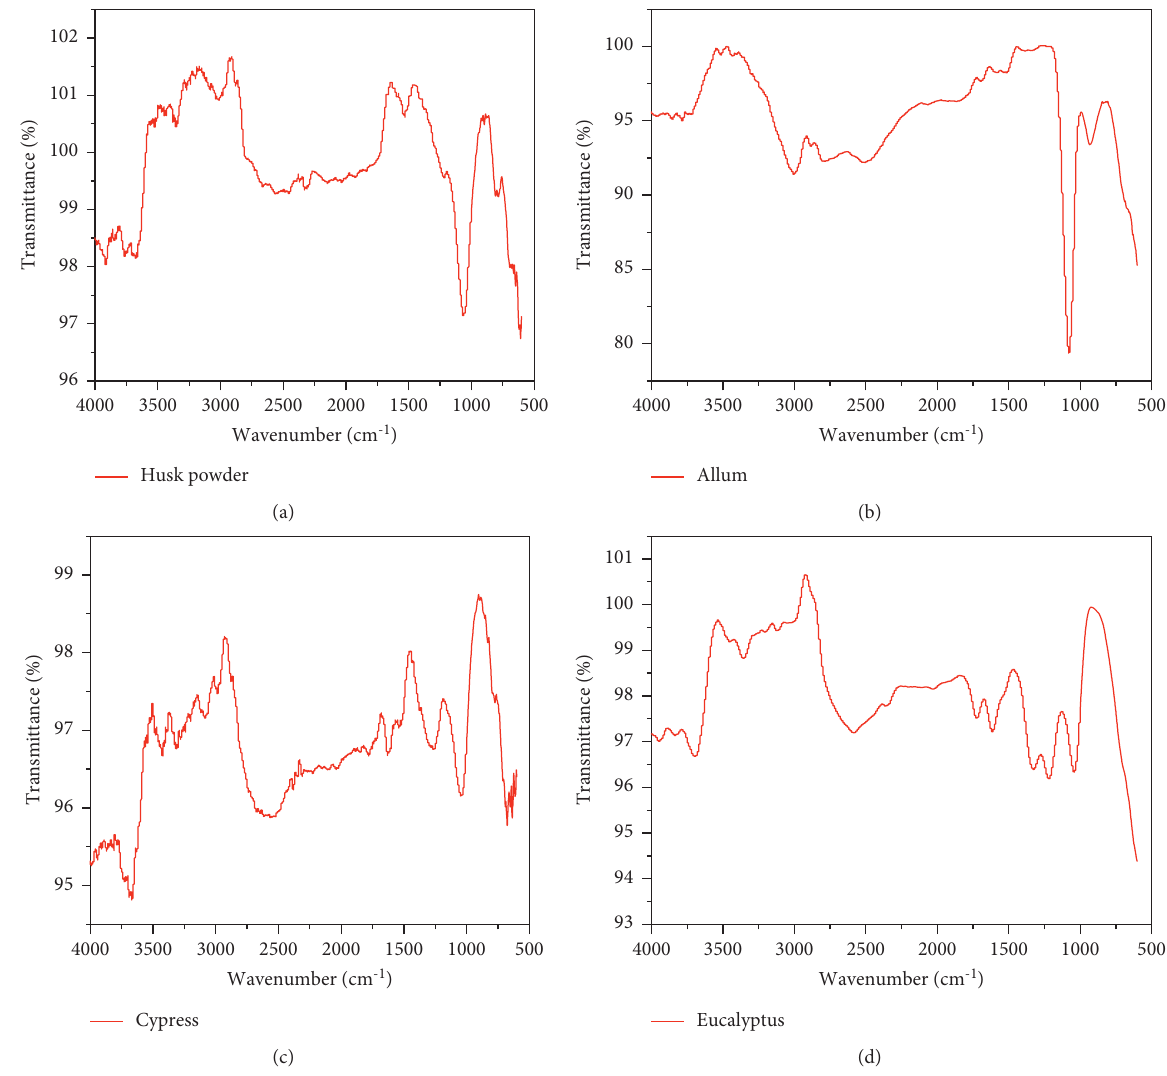
Figure 3: FTIR spectra of (a) rice husk, (b) alum, (c) cypress leaves, and (d) Eucalyptus rice husk mixture. Corresponding turbidity reductions were Figure 4(b), alum/rice husk reduced turbidity from 37.3 observed for alum/cypress mixed coagulants, from 37.3 NTU to 10.6 NTU with 0.05 g alum and 0.05 g rice husk NTU to 11.4 NTU with 0.05 g alum and 0.05 g cypress leaves mixture. This turbidity dropped to 7.3 with 0.05 alum and 5 g